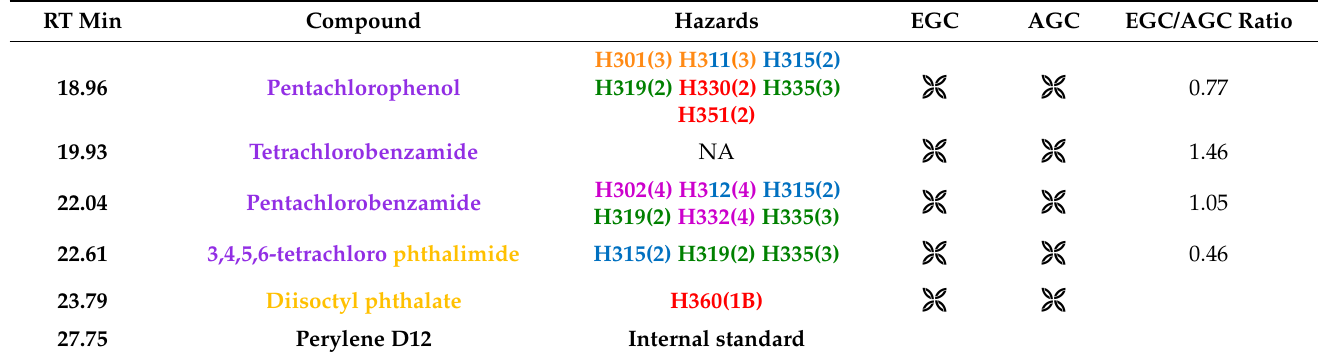
H302(4) H319(2) H335(3) H336/ H373(2)